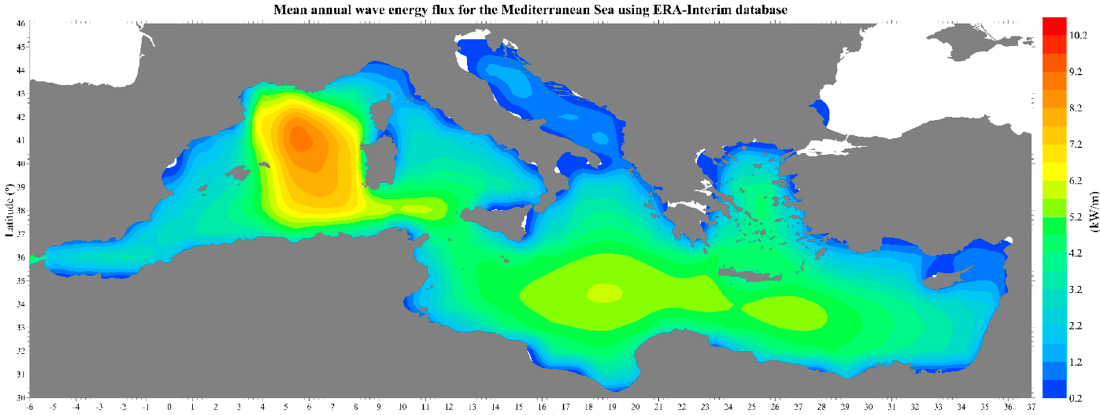
Figure 14. Mean annual wave energy flux in the Mediterranean Sea obtained from the ERA-Interim database, 1979–2013. Data analyzed by HCMR.